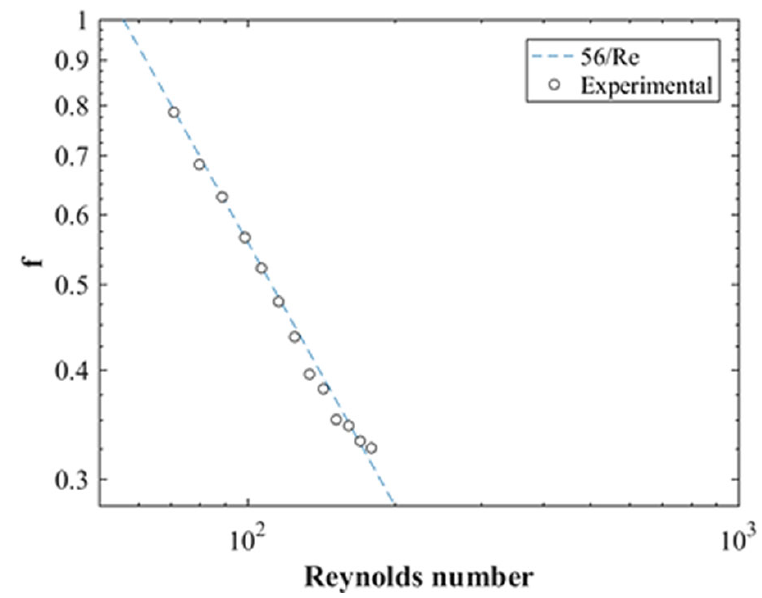
Figure 4. The comparison of the theoretical and experimental friction factor values at different Reynolds numbers.